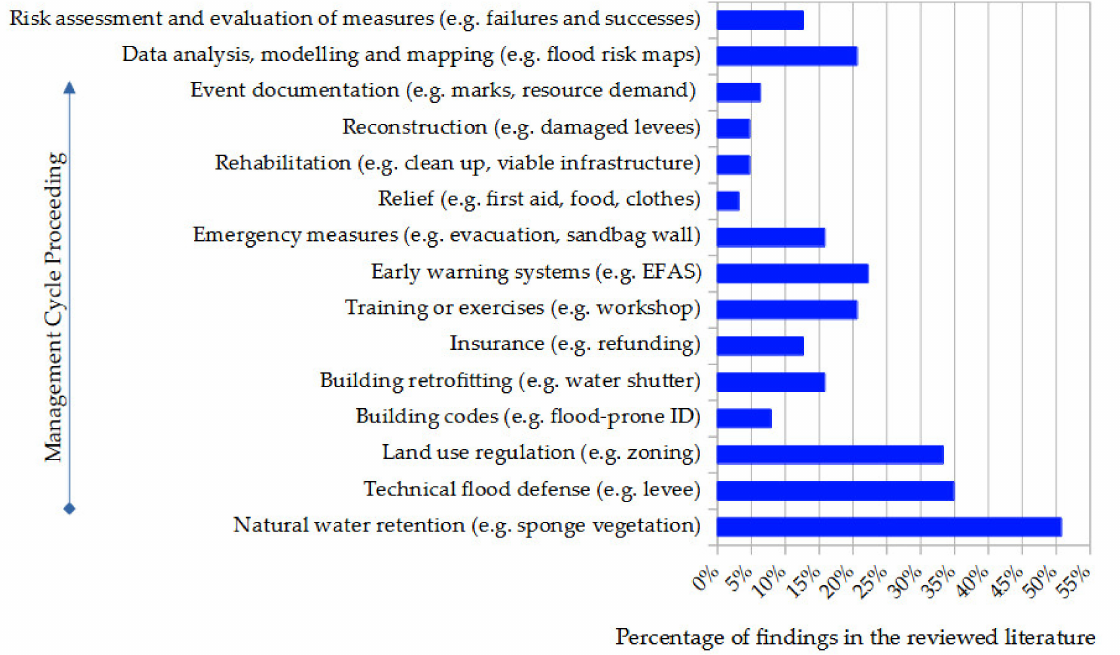
Figure 4. Percentage of literature referring to phases in the FM cycle (N =